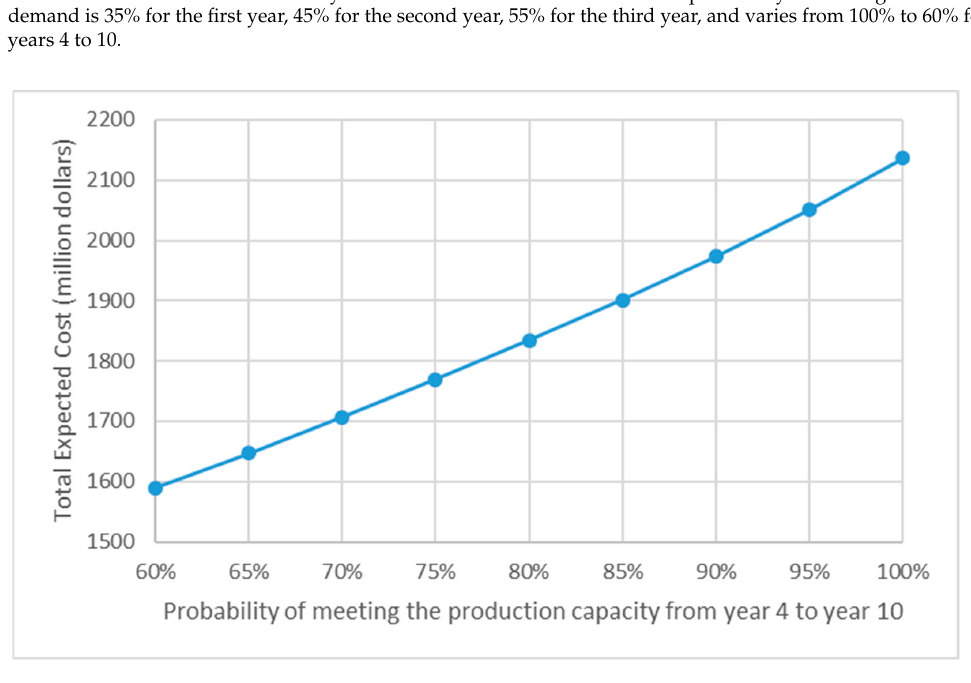
Figure 3. Trade-offs between total expected cost and probability of meeting the production capacity.